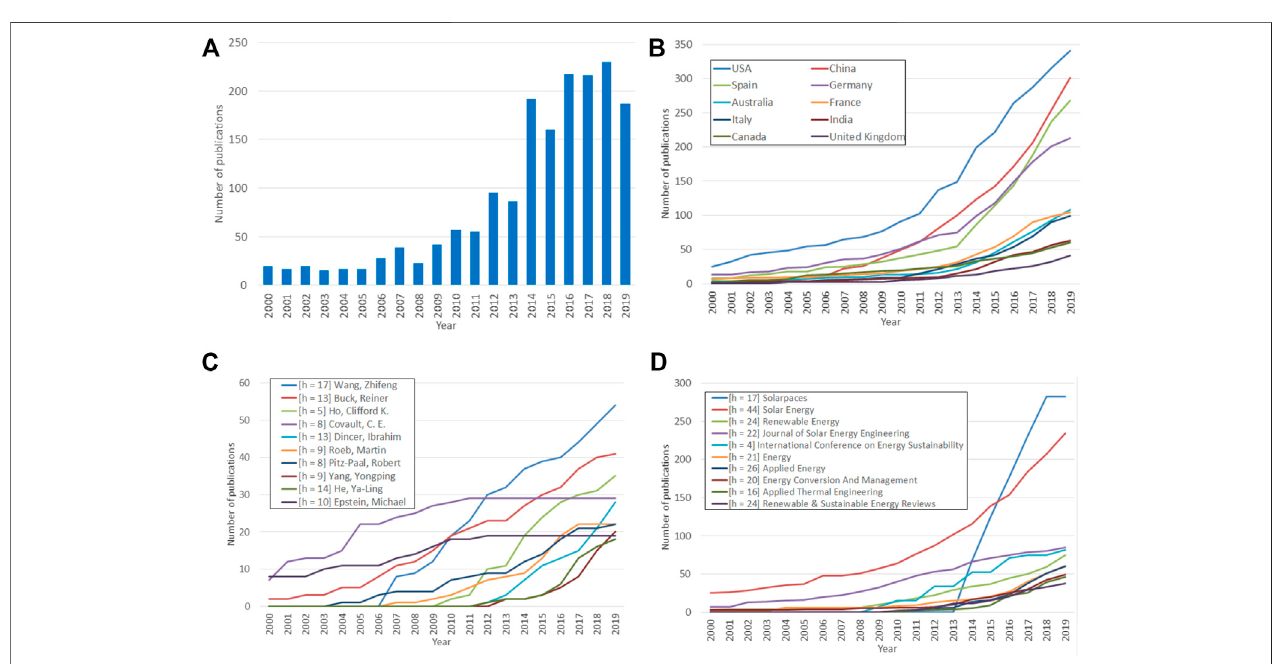
FIGURE 13 | (A) Total publication evolution in the solar tower fi eld per year; (B) Total publications in the solar tower per country; (C) Publication evolution per authors for solar tower; (D) Cumulative author evolution in the solar tower fi eld by number of publications.